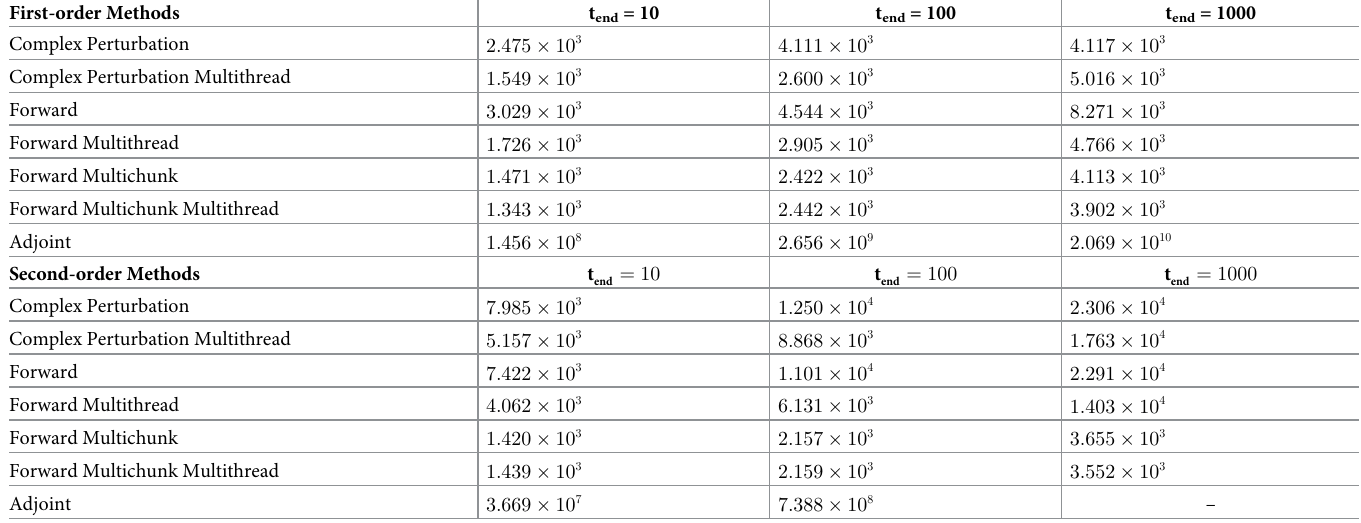
Table 4. Computational time ( μ s) for the ROBER ODE model. Parameters match those previously introduced in this manuscript. Multithread refers to parallelism across parameters. Multichunk refers to parallelism across compartments. We invoke the Julia solver Rodas4(autodiff = false) with a tolerance of 1 × 10 − 7 , reflecting the convergence tolerance. Second-order adjoint method not included at t = 1000 due to time constraints. For the second-order adjoint method, the ForwardDiffO- verAdjoint(QuadratureAdjoint(autodiff = false) solver option was used.